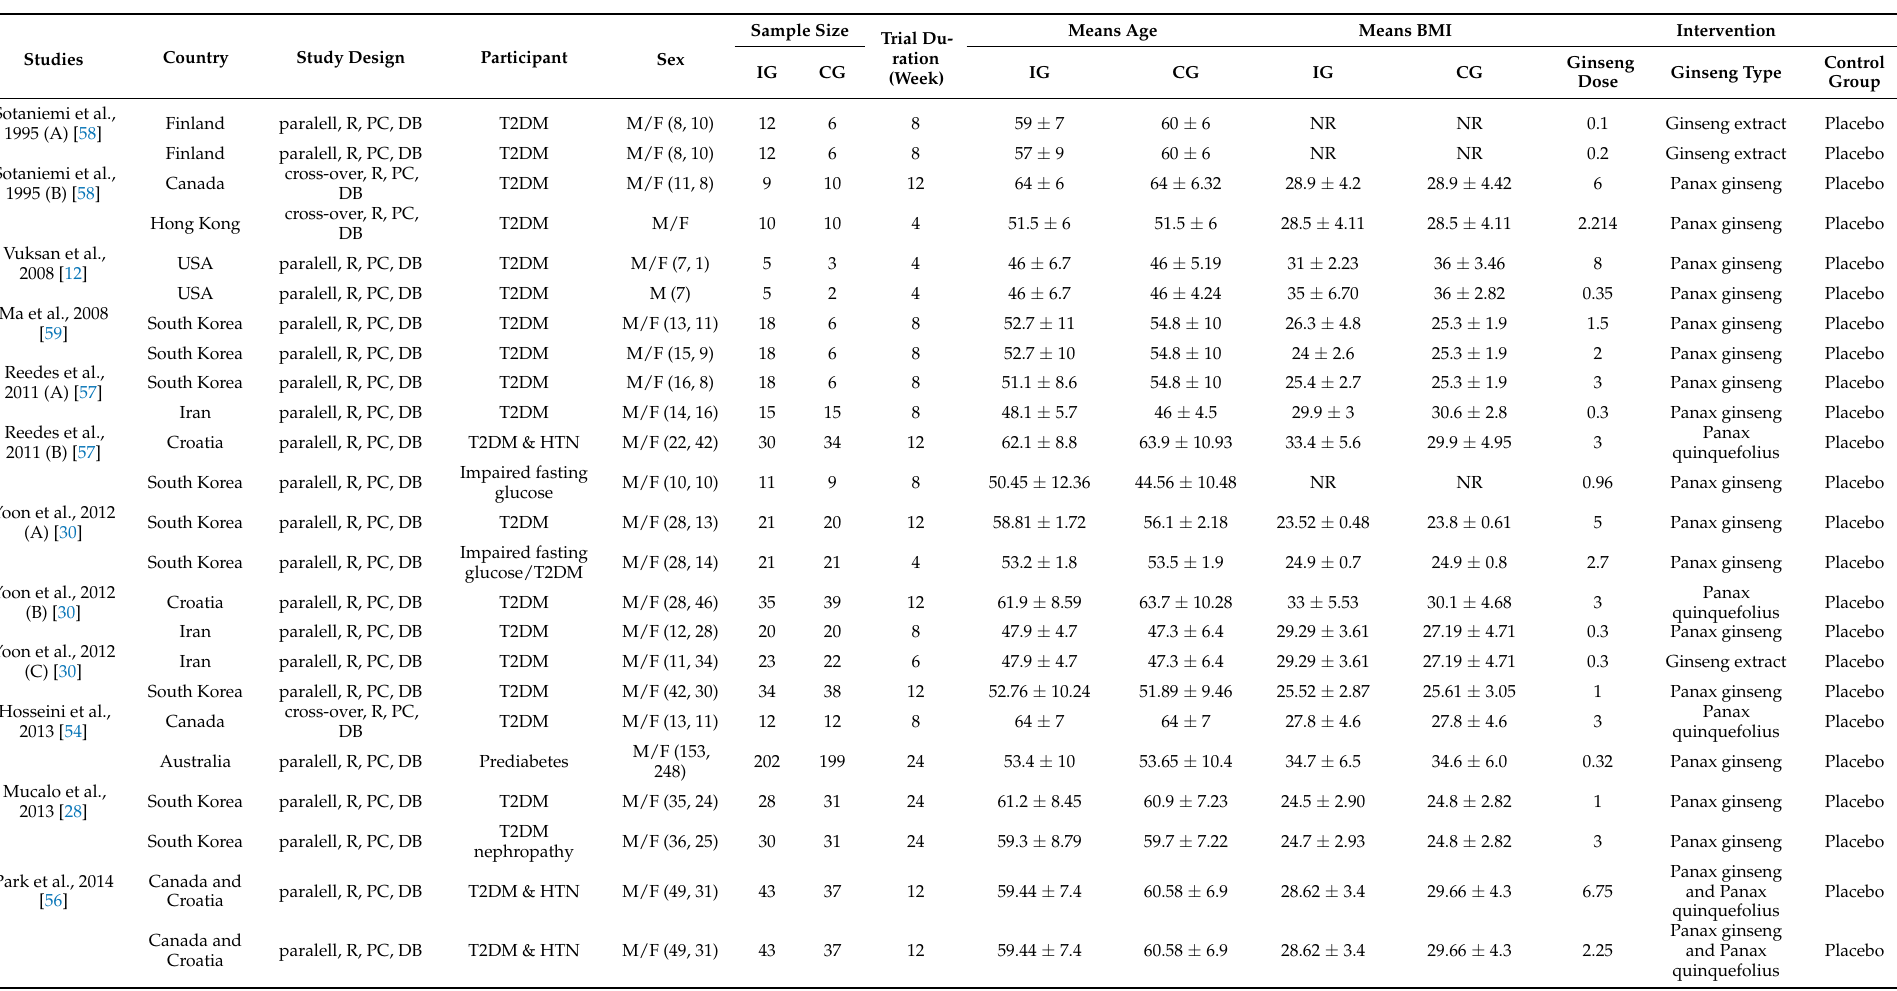
Table 2. Characteristics of the included